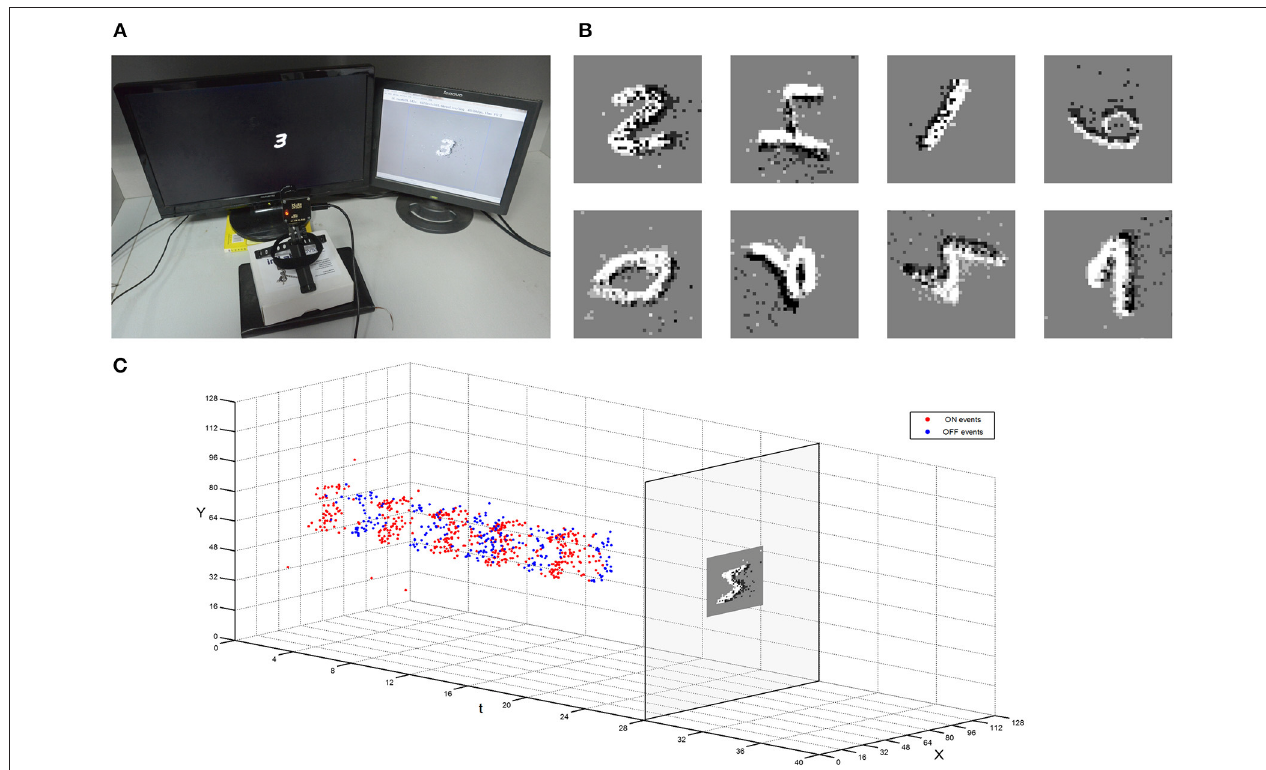
FIGURE 9 | Experiment setup of capturing the moving MNIST dataset by DVS. (A) A DVS records the moving digit on an LCD monitor. (B) Example of different moving MNIST digits captured with DVS. (C) The procedure of the restoration from the collected events to a snapshot.